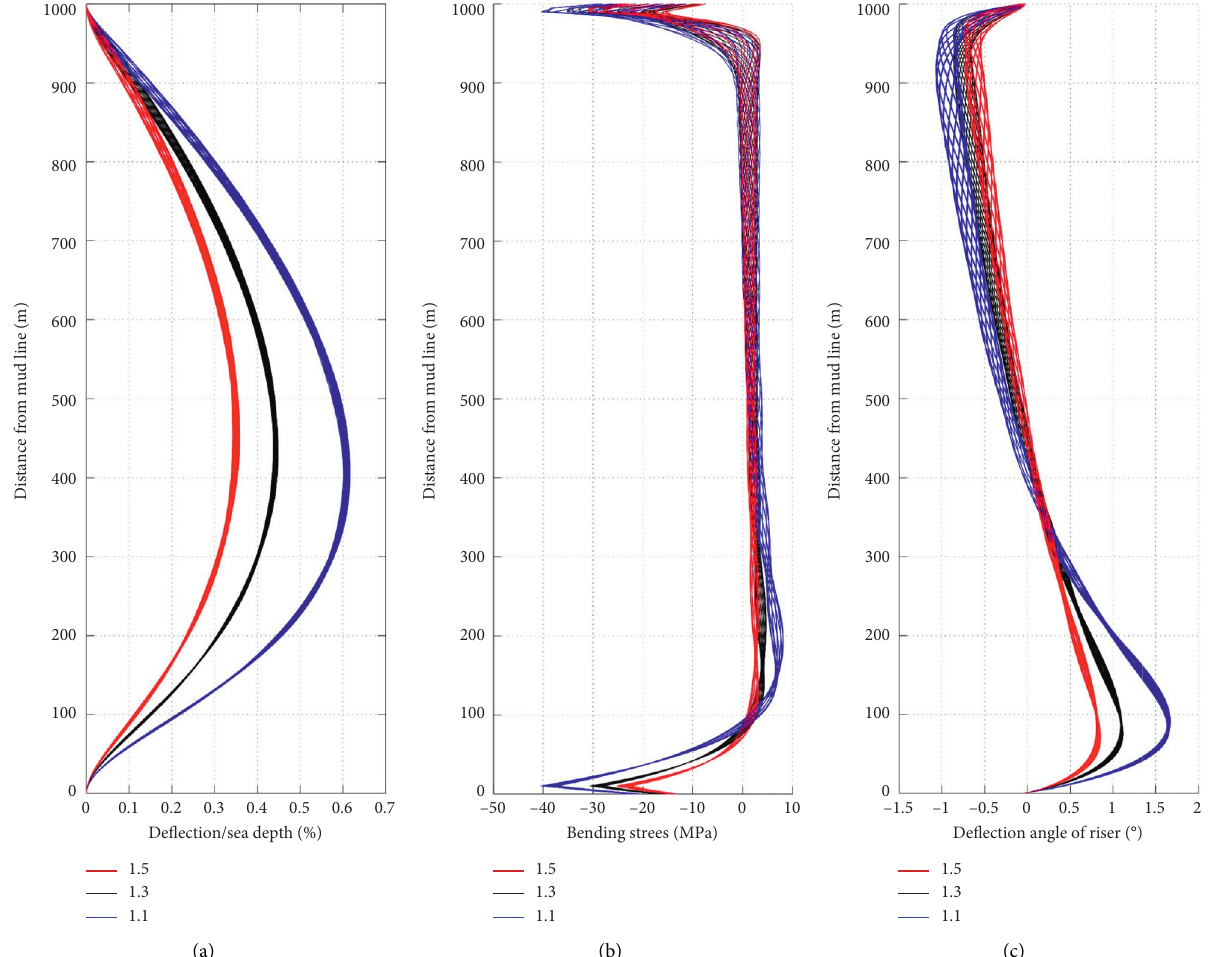
Figure 7: Comparison of dynamic responses for risers with different top tension ratios, (a) distribution of lateral deflection, (b) distribution of bending stress, and (c) distribution of deflection angle of the